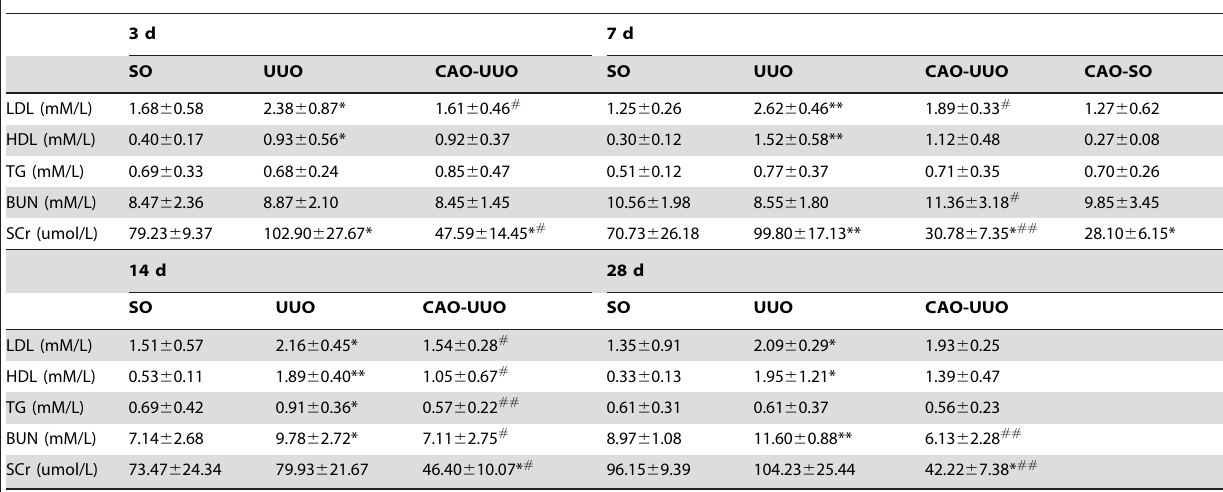
Table 1. Serum clinical chemistry